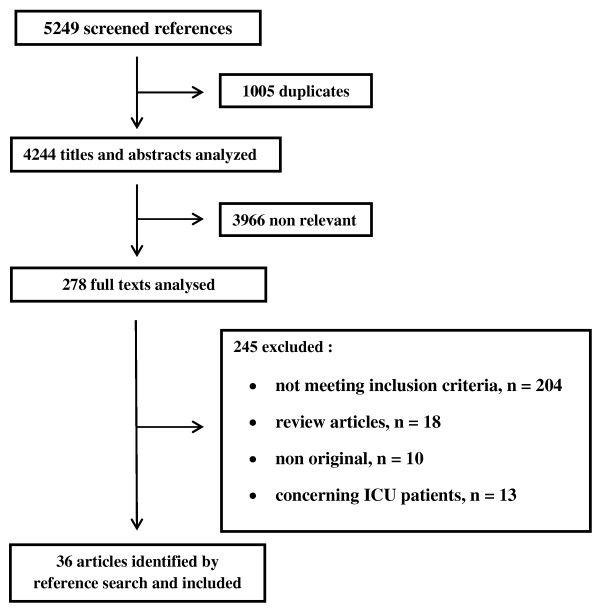
Study flow chart.